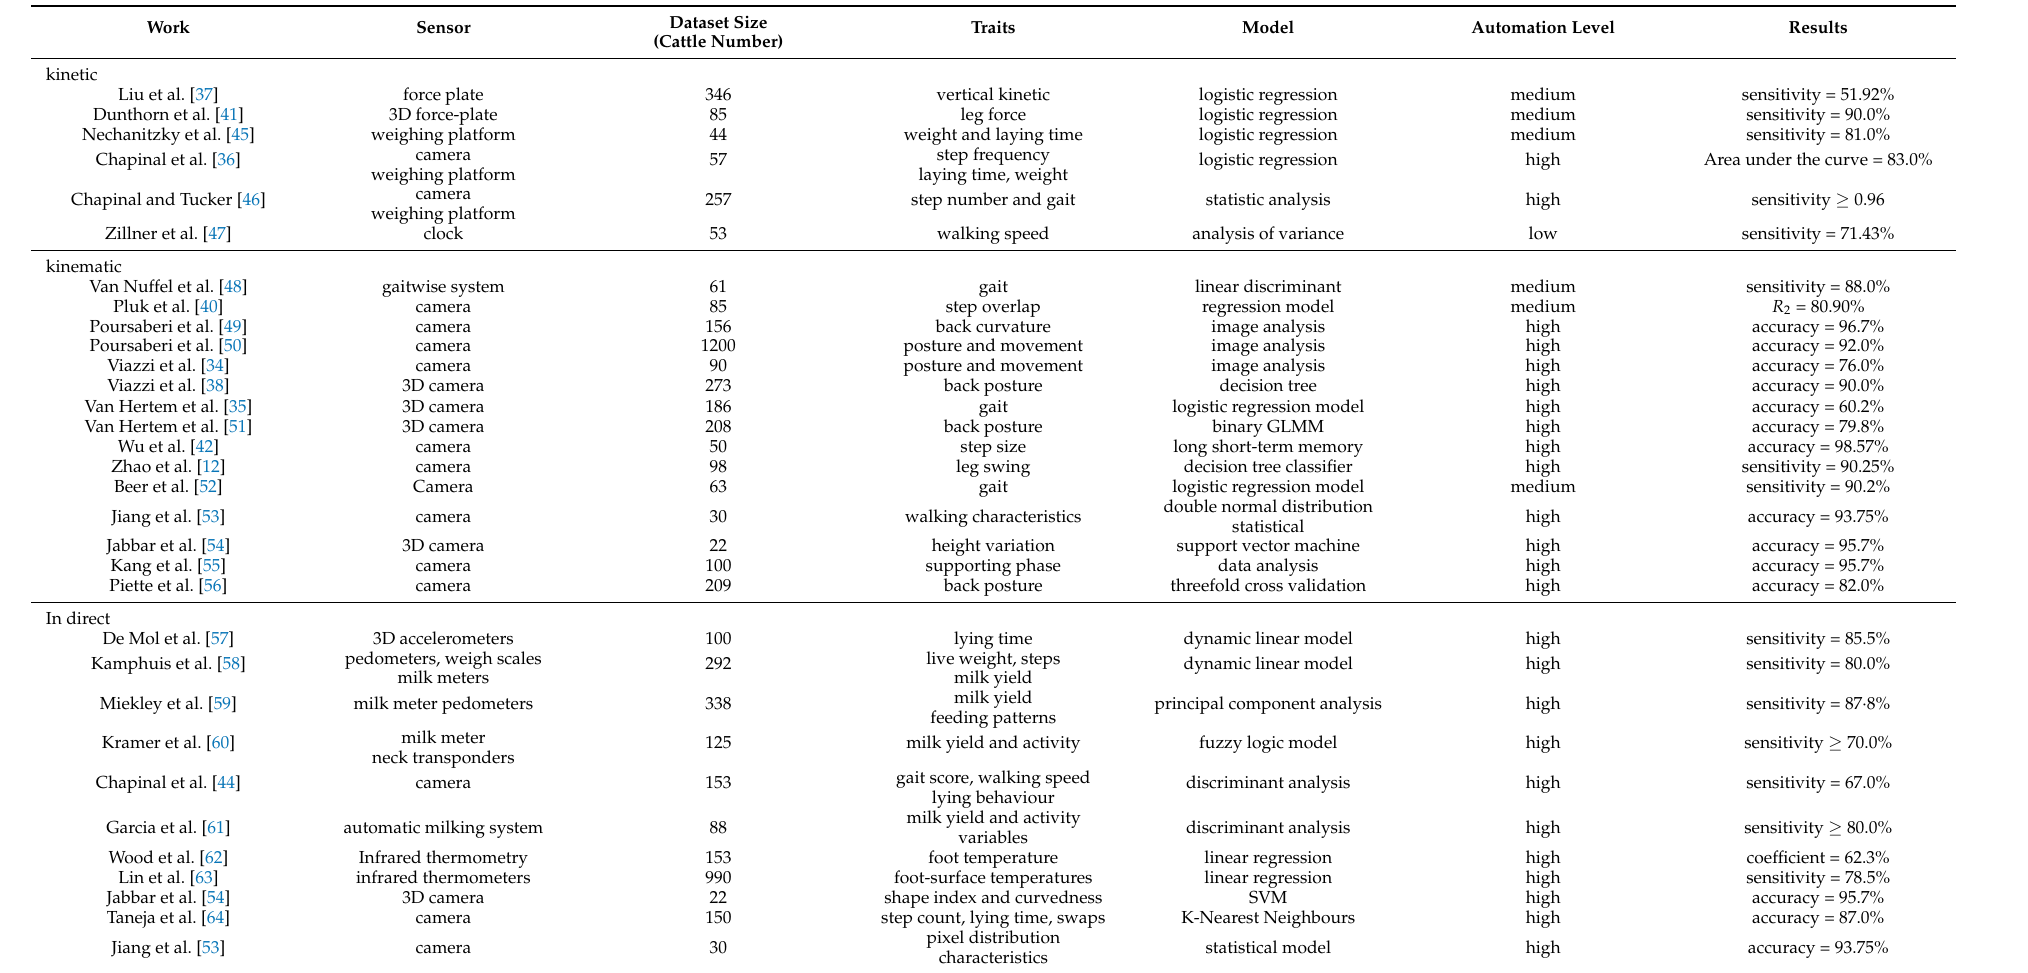
Table 1. Main studies on lameness